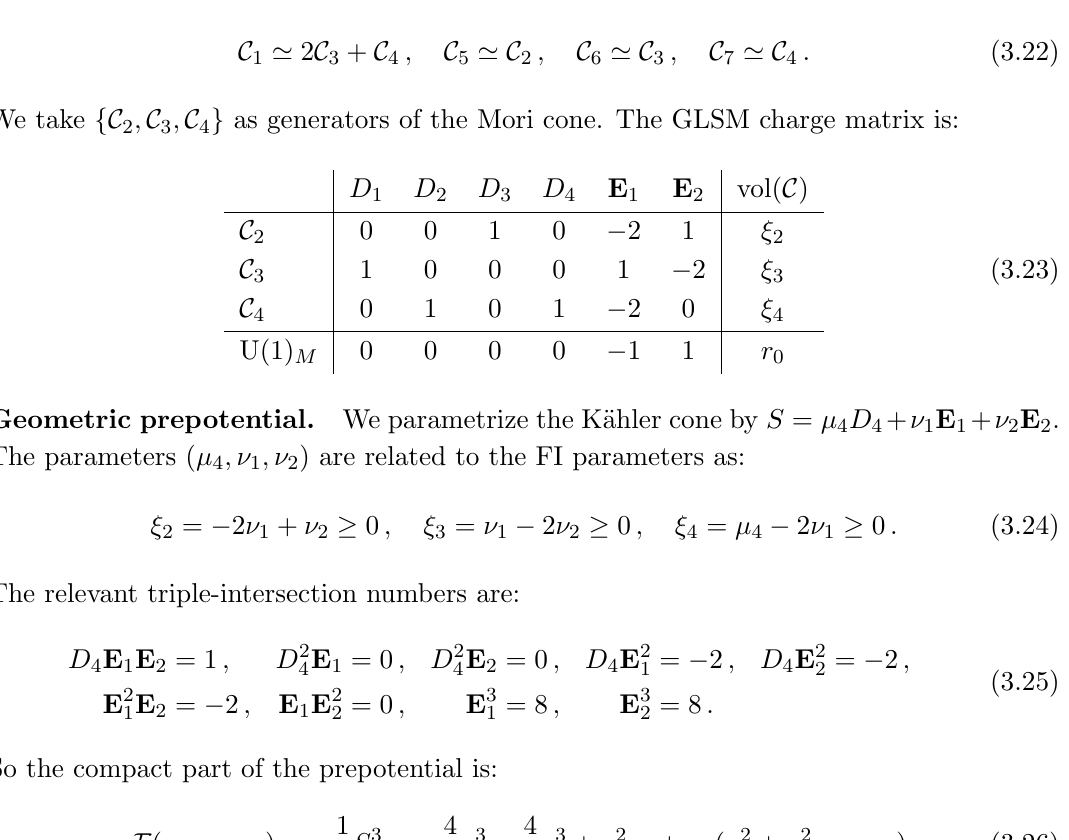
are given by the intersection pairings of the divisors they connect in C D 1 , E 1 etc.), and can be read o(cid:11) 1 = E 2 7 = E 2 C (cid:1) C (cid:1)